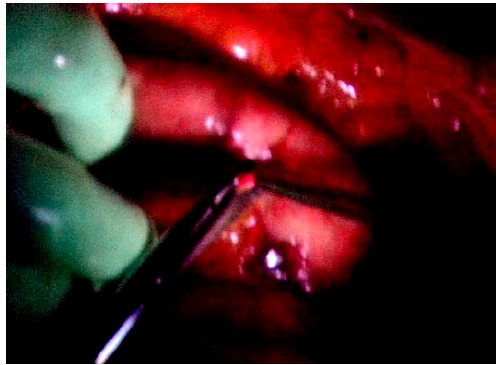
Figure 8. ALA guided cytoreductive surgery. Residual small nodules are removed under ALA PDD after macroscopic complete resection of PM under white light.